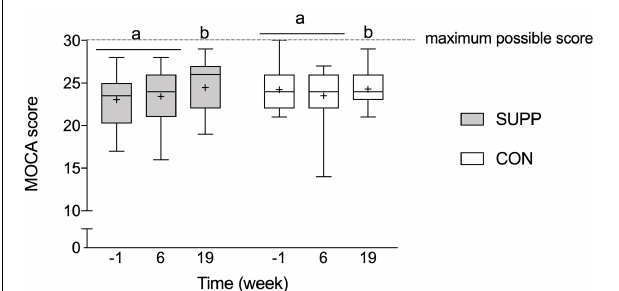
FIGURE 3 | Montréal Cognitive Assessment performance. Scores of 26 or more (out of a possible 30-point total) are considered normal; scores < 26 indicate possible MCI. Boxes (SUPP: gray; CON: white) represent interquartile (25th to 75th percentile) ranges, with the horizontal lines indicating the median. Whiskers represent the maximal and minimal values, and the cross indicates the mean. Dissimilar letters denote changes over time within a given treatment group (SUPP or CON). MOCA, Montréal Cognitive Assessment; MCI, mild cognitive impairment; SUPP, supplement; CON,